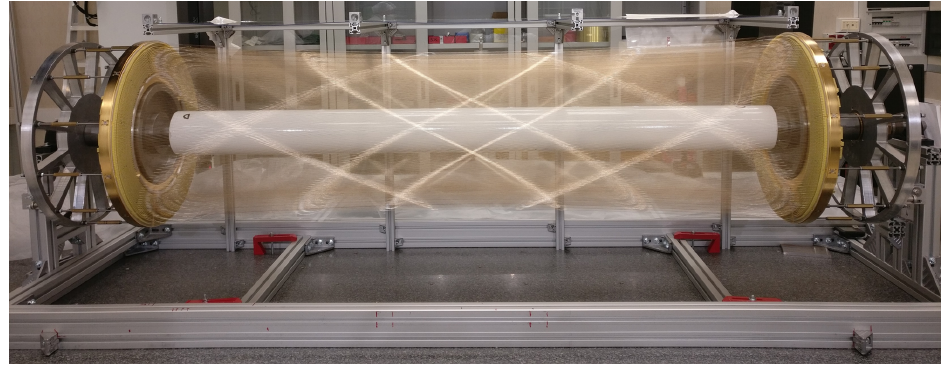
Figure 3. The fully wired MEG II